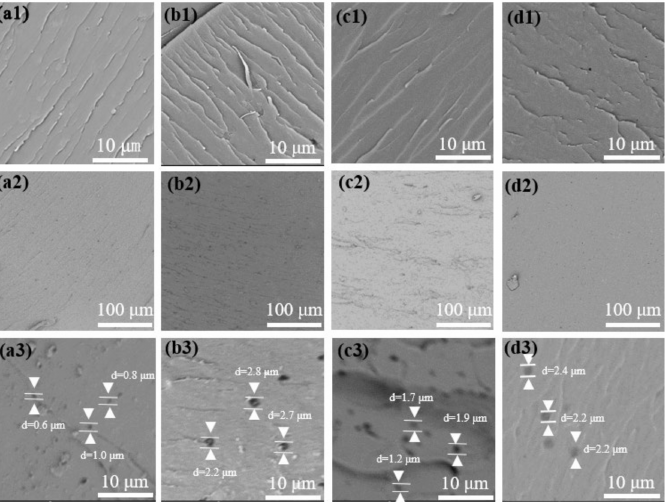
Figure 8. SEM section images of ( a1 – a3 ) EP/PolyTi1, ( b1 – b3 ) EP/PolyTi2, ( c1 – c3 ) EP/PolyTi3, and ( d1 – d3 ) EP/PolyC before and after etching.